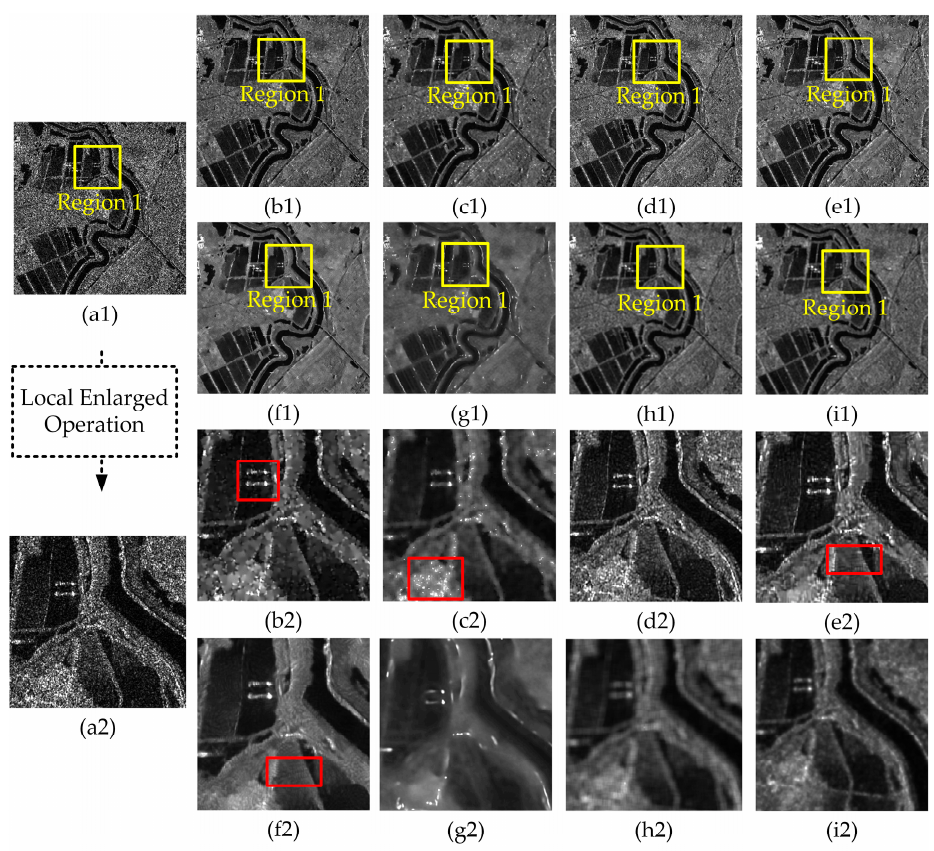
Figure 8. ( a1 ) GF-3 original image. Images were filtered using ( b1 ) DPAD, ( c1 ) EnLee, ( d1 ) SAR-